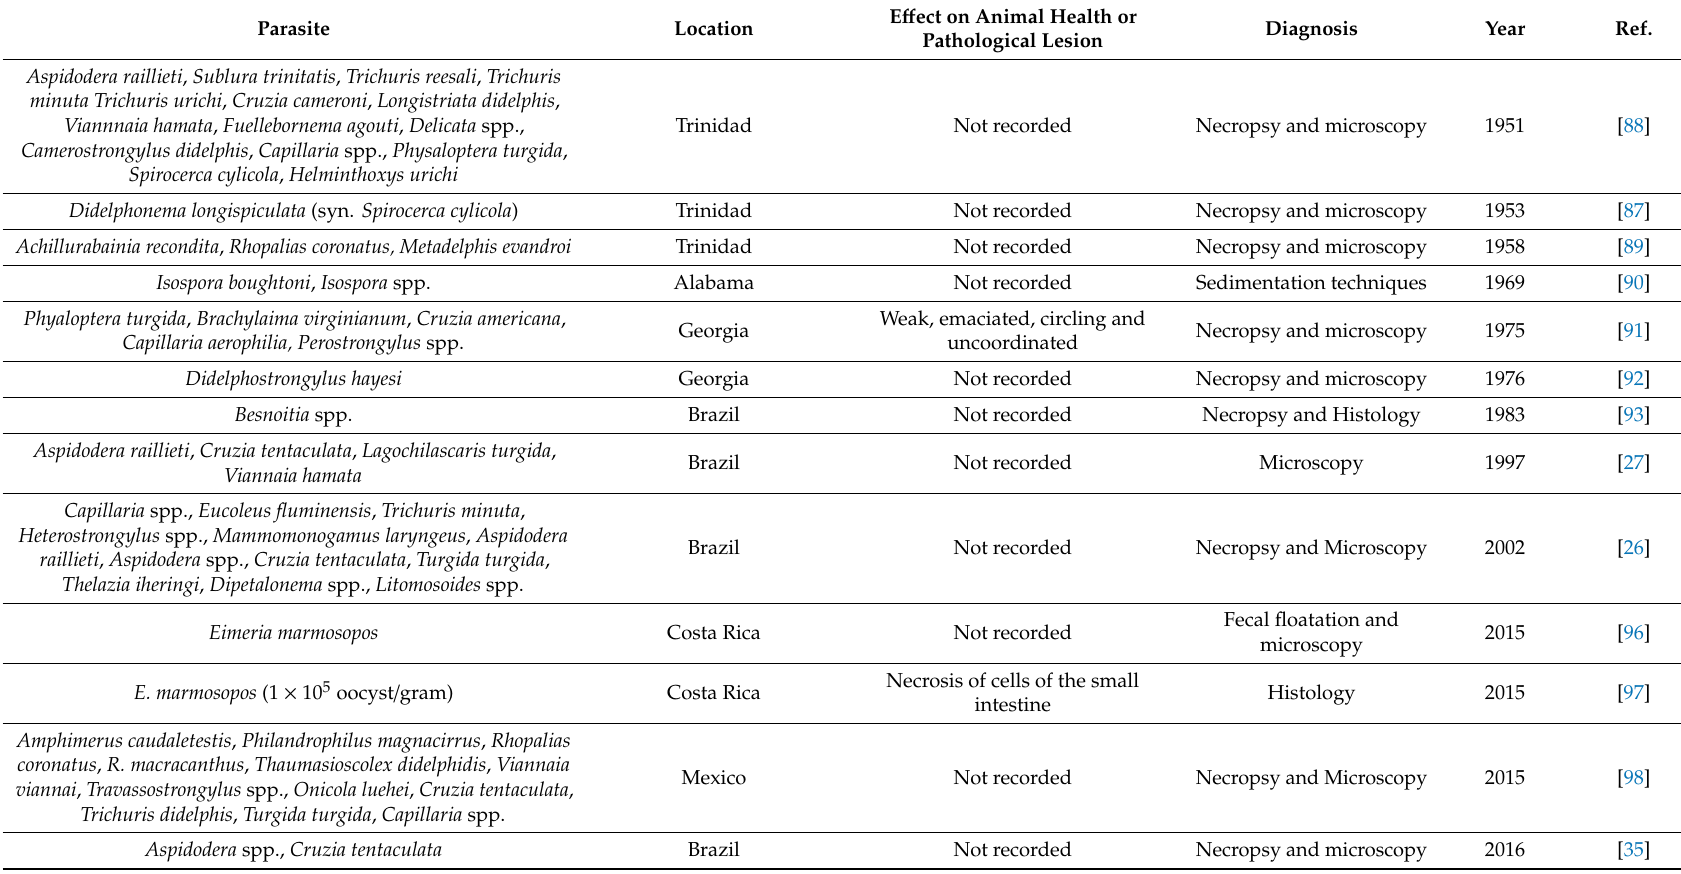
Table 4. Endoparasites found in the Manicou ( Didelphis marsupialis insularis / D. marsupialis ) at di ff erent